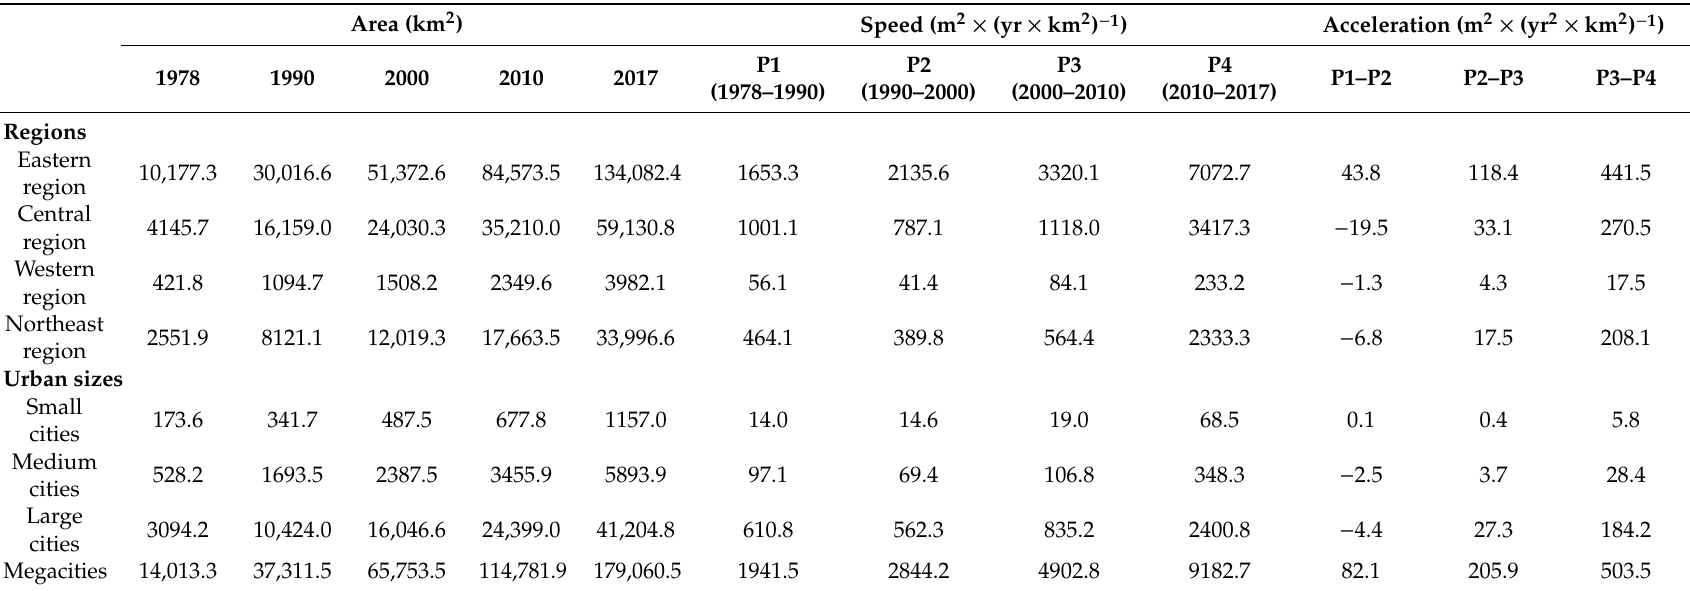
Table 4. Comparisons of the area, speed, and acceleration by regions and urban